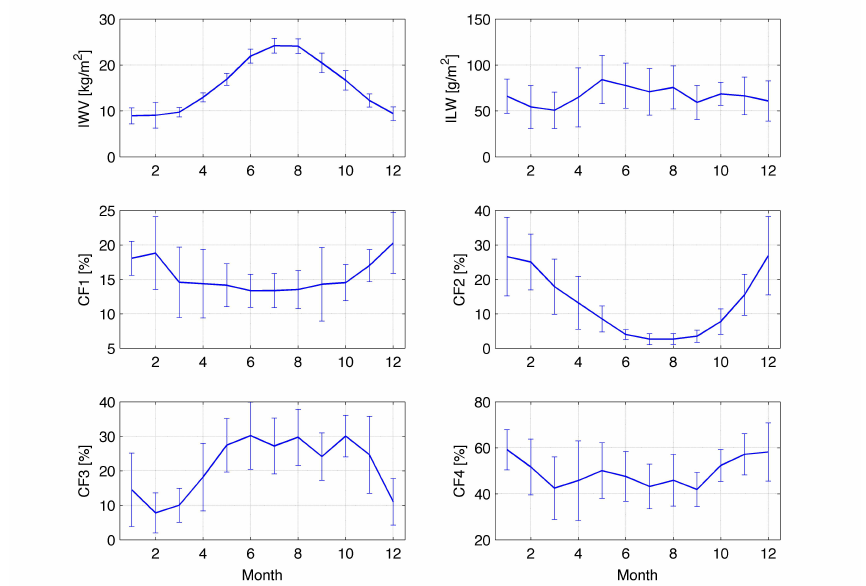
Figure 2. Climatologies of integrated water vapour (IWV), integrated liquid water (ILW) and cloud fraction (CF) of four cloud categories (defined in the text) observed by the TROWARA radiometer in Bern from 2004 to 2016. The error bars indicate the standard deviation of the monthly mean from year to